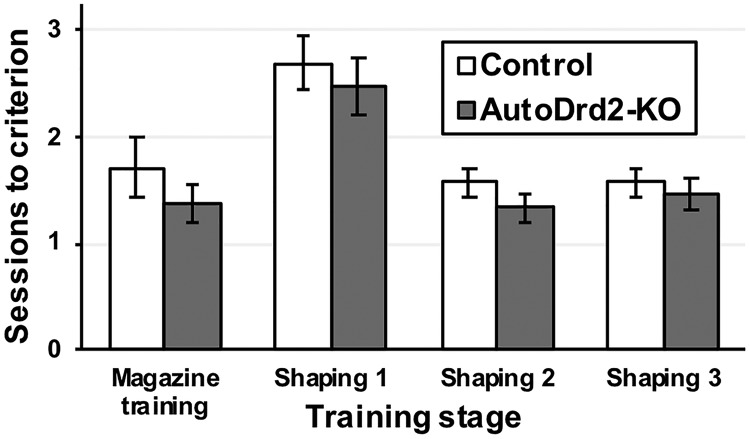
Shaping of the operant response. Genotype had no effect on the total number of sessions needed to learn the operant response (p < 0.265). However, when both groups were considered together, the first stage of shaping (shaping 1) took significantly longer than any other stage (all p < 0.01). Bars show group means ± SEM.